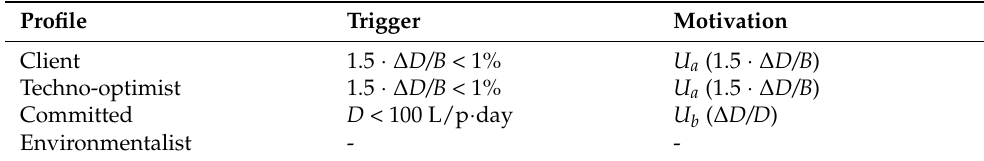
Table A5. Abandonment process parameters according to value profile.